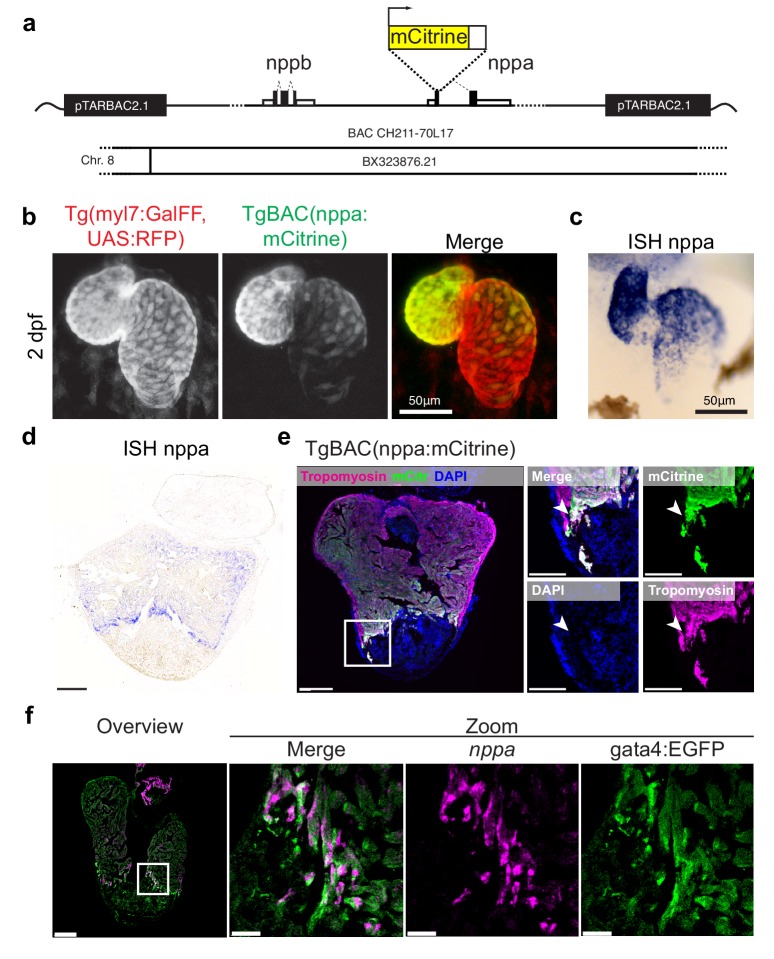
TgBAC(nppa:mCitrine) expression recapitulates endogenous nppa gene expression.(a) Design of the bacterial artificial chromosome (BAC) used for generation of the transgenic line TgBAC(nppa:mCitrine). (b) Transgenic mCitrine expression in the heart in relation to RFP expression in the whole myocardium of Tg(myl7:GFF, UAS:RFP, nppa:mCitrine) in embryos at 2 days post-fertilization (dpf). (c) Whole mount in situ hybridization for endogenous nppa expression in embryos at two dpf. Note the specific expression in ventricle and atrium and absence of expression in atrioventricular canal of the nppa:mCitrine transgene expression (in panel b) as well as for the endogenous nppa expression (in panel c). (d, e) Endogenous nppa expression (d) and nppa:mCitrine expression (e) in the adult heart at 7 days post-injury (dpi). Note expression of nppa:mCitrine in the cortical borderzone (arrowheads). (f) Fluorescent in situ hybridization for nppa performed on gata4:EGFP hearts 7dpi. Note the overlap of nppa and gata4:EGFP in trabecular borderzone cardiomyocytes.